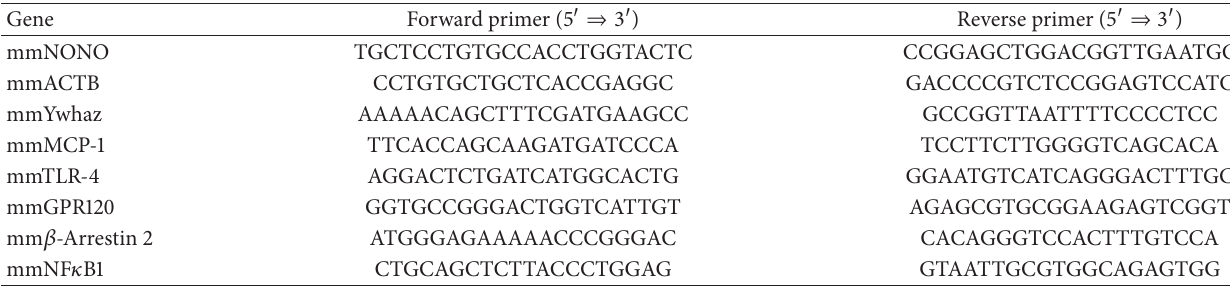
Table 1: Real-time PCR primer